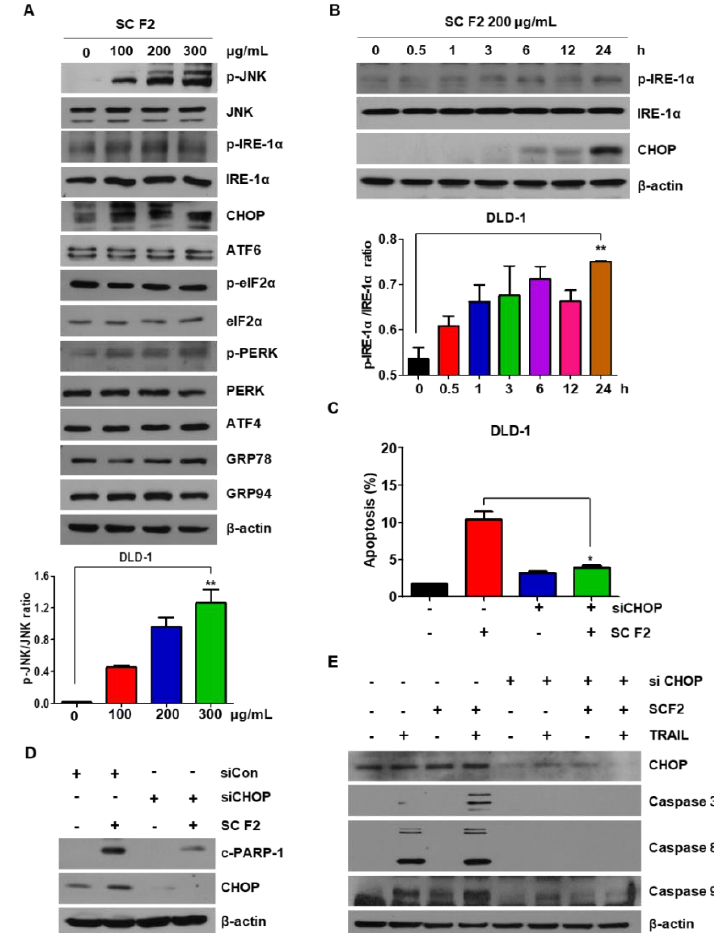
Figure 3. SC F2-induced C/EBP-homologous protein (CHOP) up-regulation is mediated through selective induction of IRE1 α -JNK endoplasmic reticulum (ER) stress signaling. DLD-1 cells